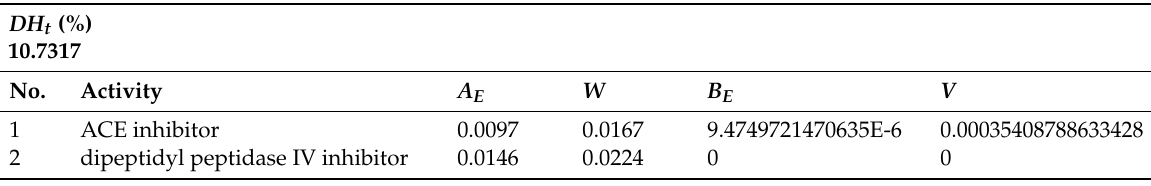
Table A20. A E , DH t , W , B E and V values from RubisCO of Halophila stipulacea . In silico enzymatic cleavage was carried out by